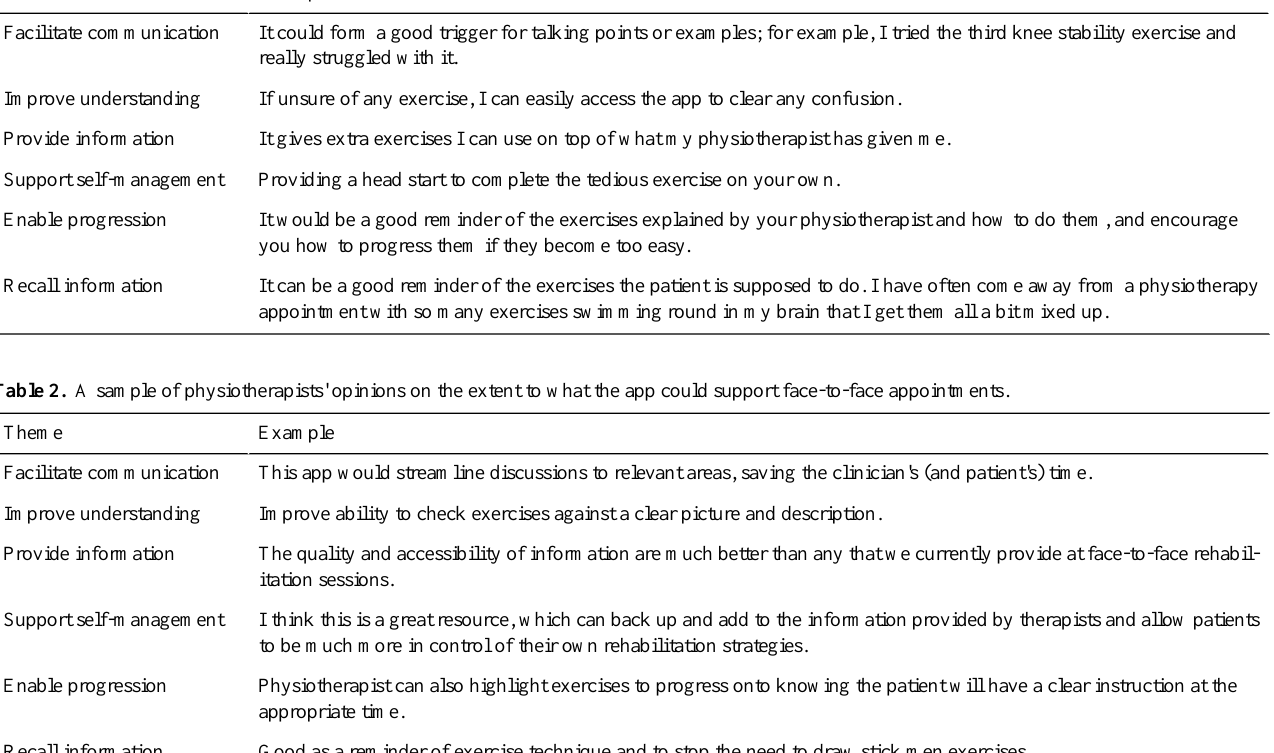
Table 1. A sample of patients' opinions on the extent to what the app could support face-to-face appointments. ExampleTheme